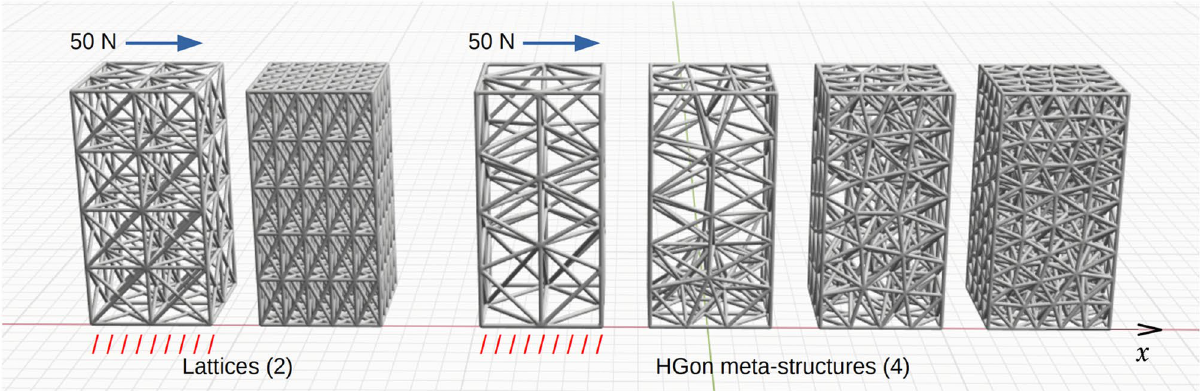
Figure 8. Two rectangular FCC lattices and four HGon meta-structures with increasing density were generated. Each of these structures had exact same applied ramp-and-release loading conditions in the X direction (arrows) and fixed bottom faces as indicated. For the lattices; 4 × 2 and 5 × 5 cells were computed. For the Hgons; 5 × 3, 6 × 4, 8 × 5, and 10 × 6 node densities were